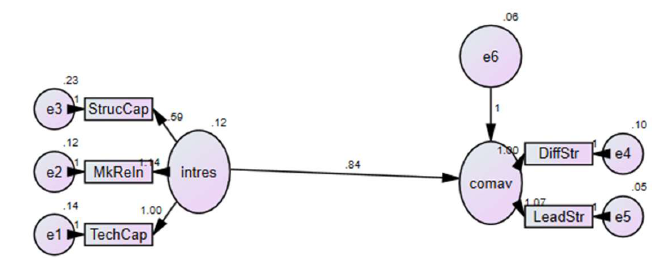
Fig. 2. The results of the analysis